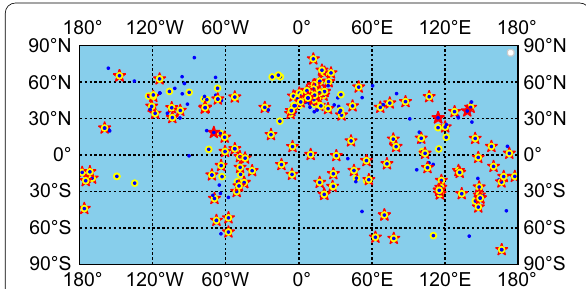
Fig. 2 Station distribution in the reference network for estimating FCBs. The blue points denote stations tracking GPS satellites. The red stars and yellow points are for BDS-2, Galileo, respectively